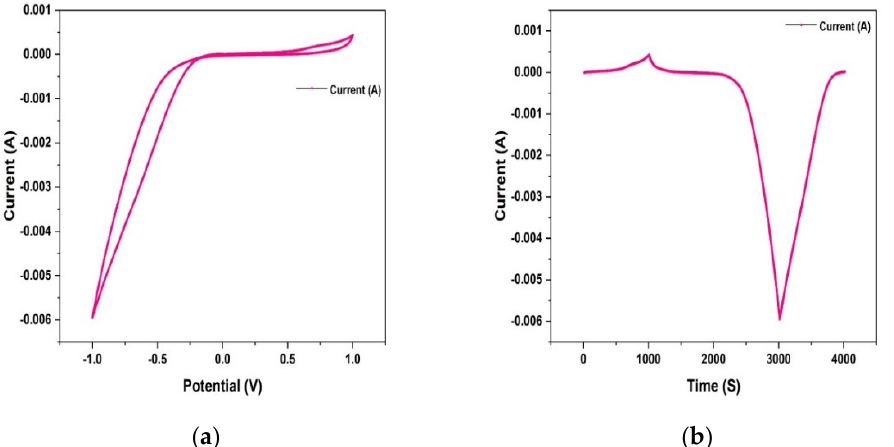
Figure 6. Current peaks over time ( a ) and cyclic voltammogram ( b ) of biochar cathode during MFC